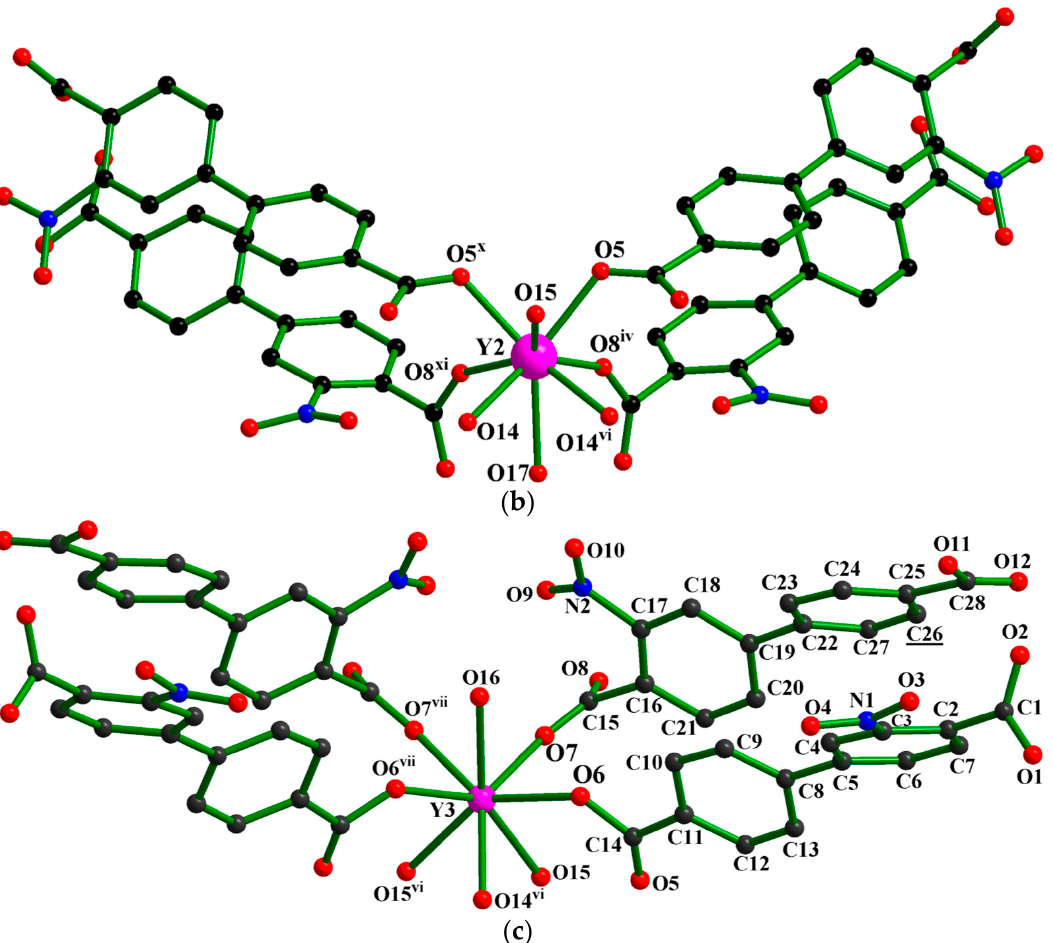
Figure 2. ( a ) The coordination environment for Y1 in 1 ; ( b ) The coordination environment for Y2 in 1 ; ( c ) The coordination environment for Y3 in 1 .